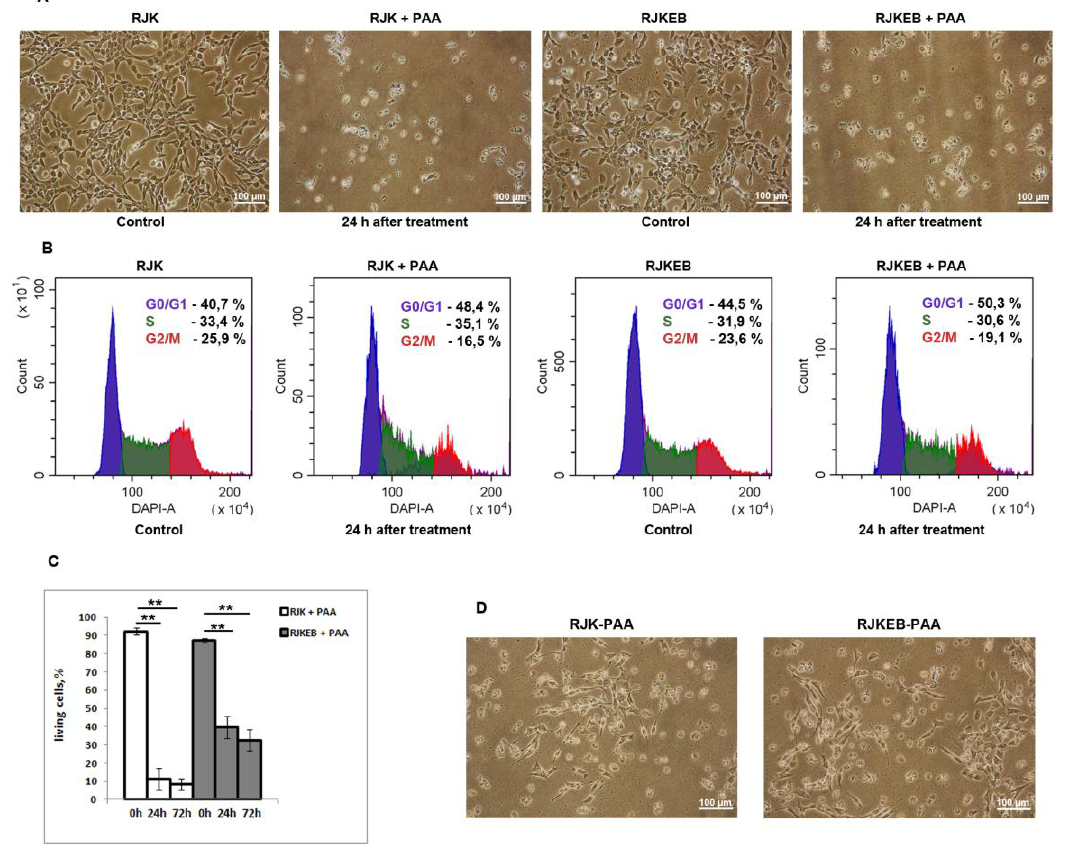
Figure 2. Analysis of RJK, and RJKEB cell populations after exposure to PAA. ( A ) Morphology of RJK and RJKEB cells 24 h after treatment with PAA. Ob. 10 × . ( B ) FACS analysis of the cell cycle 24 h after PAA treatment. ( C ) FACS analysis cell viability 24 after PAA treatment. ( D ) Morphology of RJK and RJKEB cells resumed proliferation after PAA treatment. The mean ± SD of three independent experiments are presented (** p < 0.01). Abbreviations: RJK—Chinese hamster cells CHLV-79